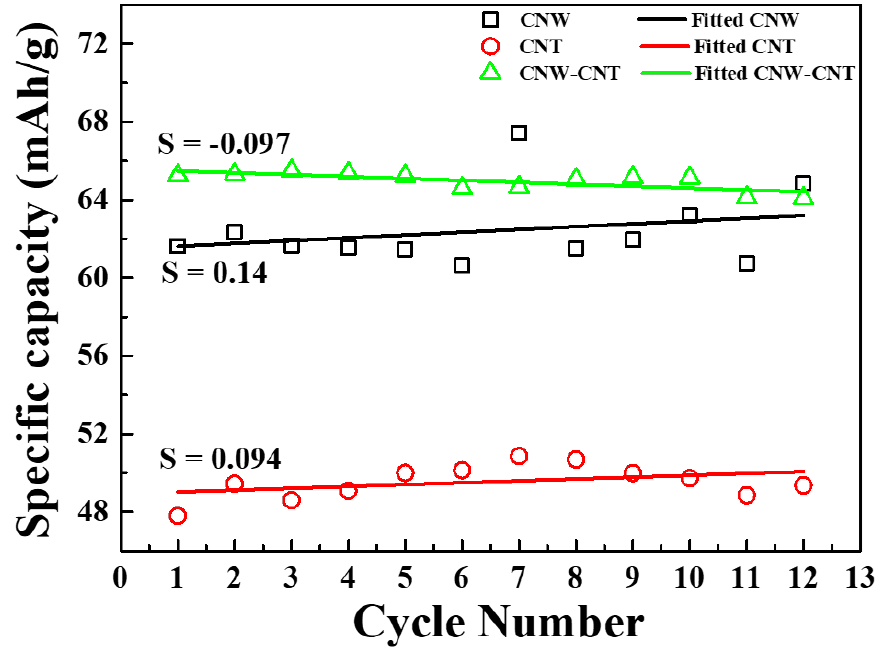
Figure 6. The Specific capacity of the CNW, CNT, and composite material for 12 cycles.